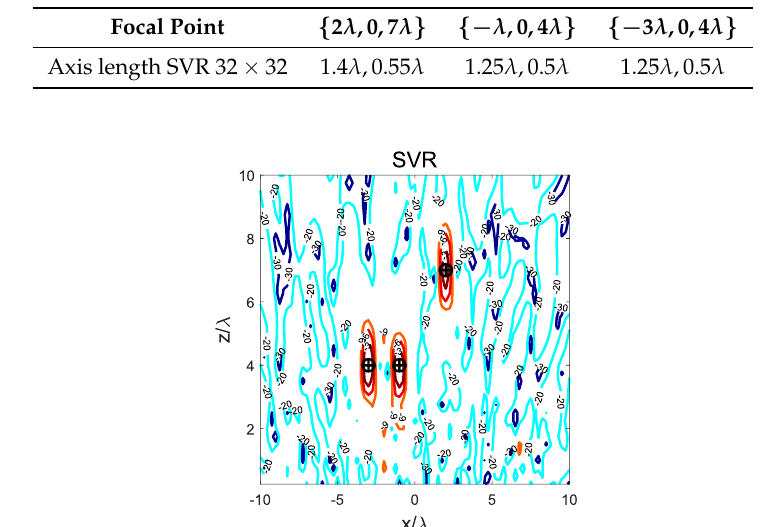
Table 2. Example #1. Axis length (major, minor) using SVR and a 32 × 32 element array.